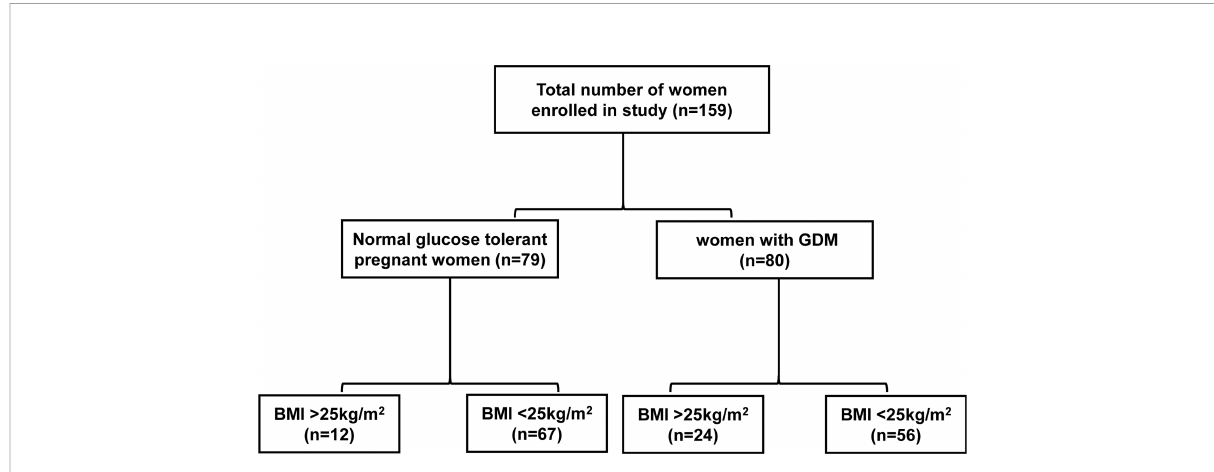
FIGURE 1 Flow chart of the study